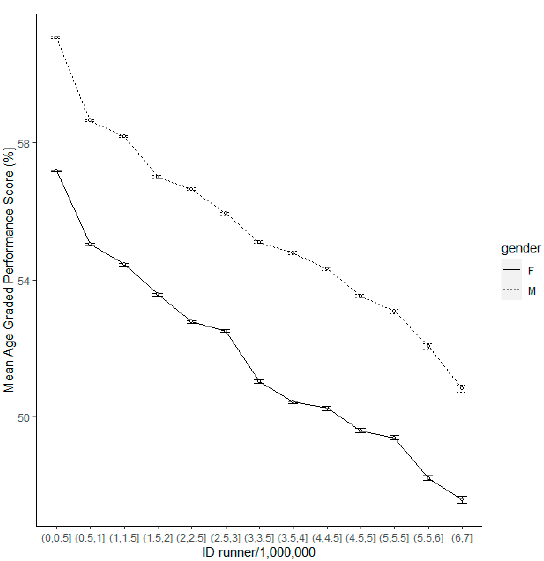
Figure 2. Mean AGPS for each registration ID cohort. Cohorts are separated into groups of 500,000 by ID number, i.e., ID numbers 1–500,000, 500,001–1,000,000 etc., so the further to the right of the graph, the more recent the cohort of registrants. Table 2. A linear mixed model of AGPS at Scottish parkrun events. Participant was included as a random effect. The final three parameters listed in the table are significant interaction terms that were also maintained in the